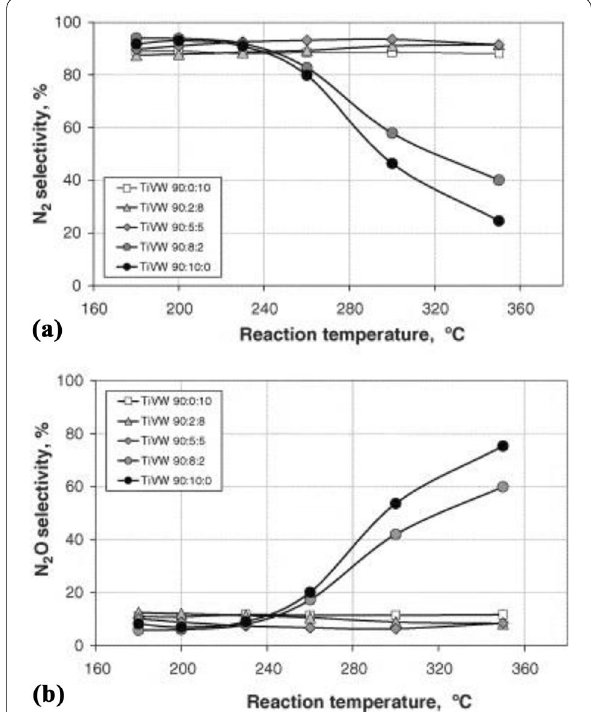
Fig. 16 Reaction temperature effect of NH3 conversion, operating condition: space velocity at normal conditions (GHSV), 15,000 h − 1 ; linear velocity, 0.1 ms − 1 ; pressure, 0.1 MPa. Feed composition: